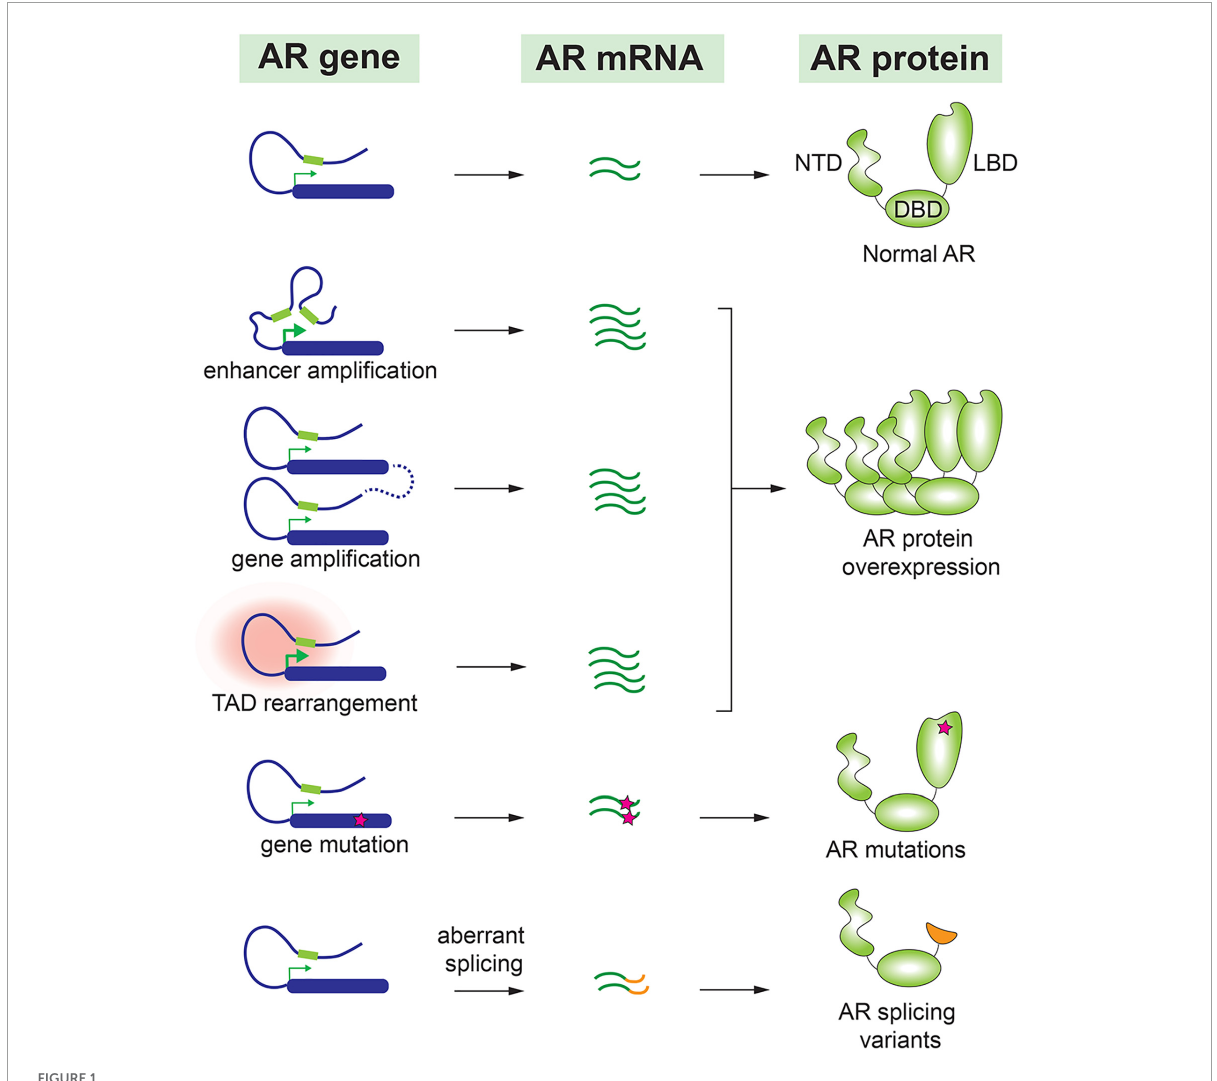
FIGURE1 Molecular alteration of AR in